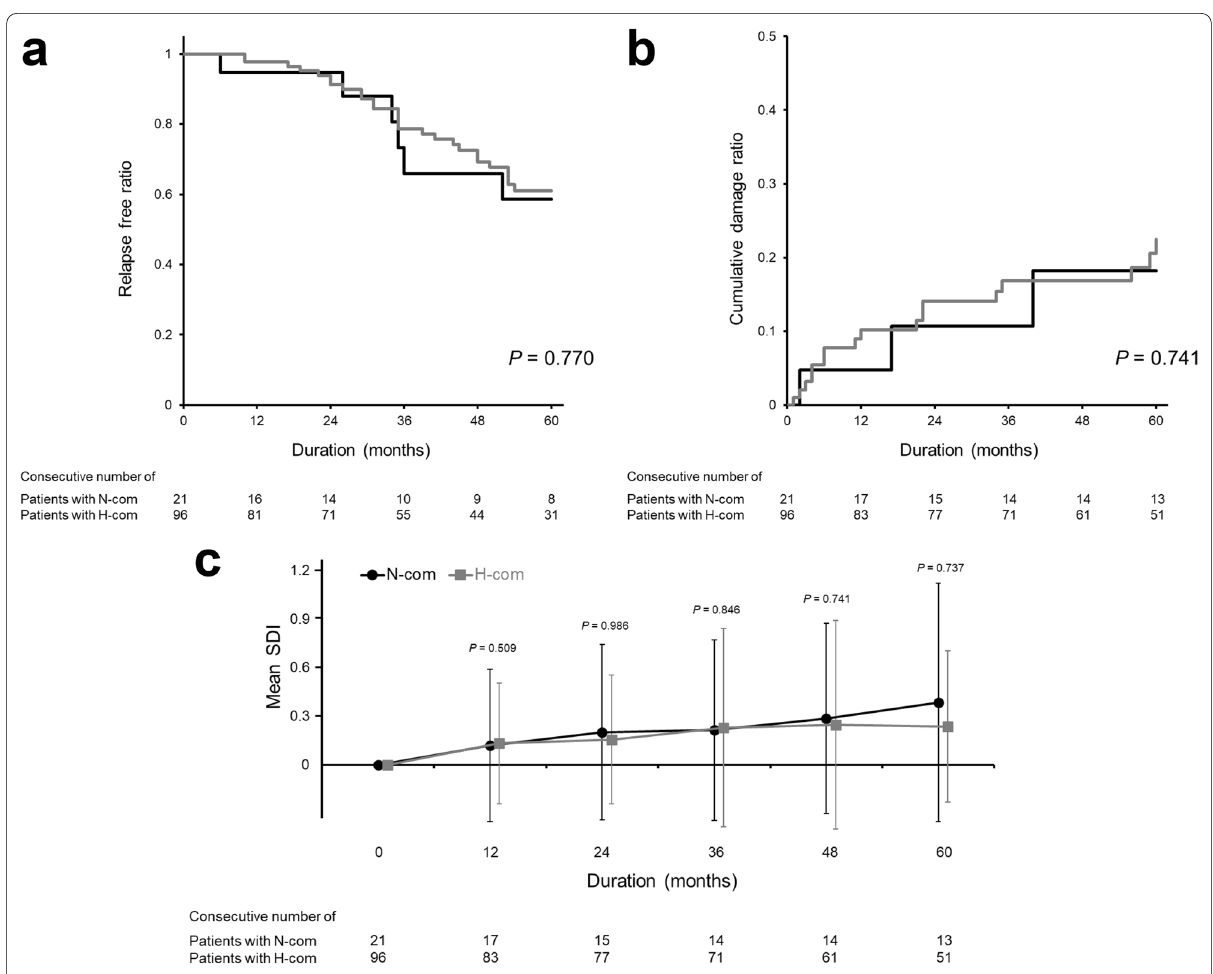
Fig. 2 Relapse and organ damage during the clinical course. Survival curves determined by the Kaplan–Meier and log-rank tests showing relapse-free ratio ( a ) and cumulative ratio of organ damage ( b ) between patients with normal serum levels of C3, C4, and CH50 (N-com, black line) and those with lower than normal serum levels of one or more complements in C3, C4, and/or CH50 (H-com, gray line). Comparisons of mean (standard deviation) the SLICC/ACR Damage Index (SDI) between patients with N-com and those with H-com during the clinical course ( c